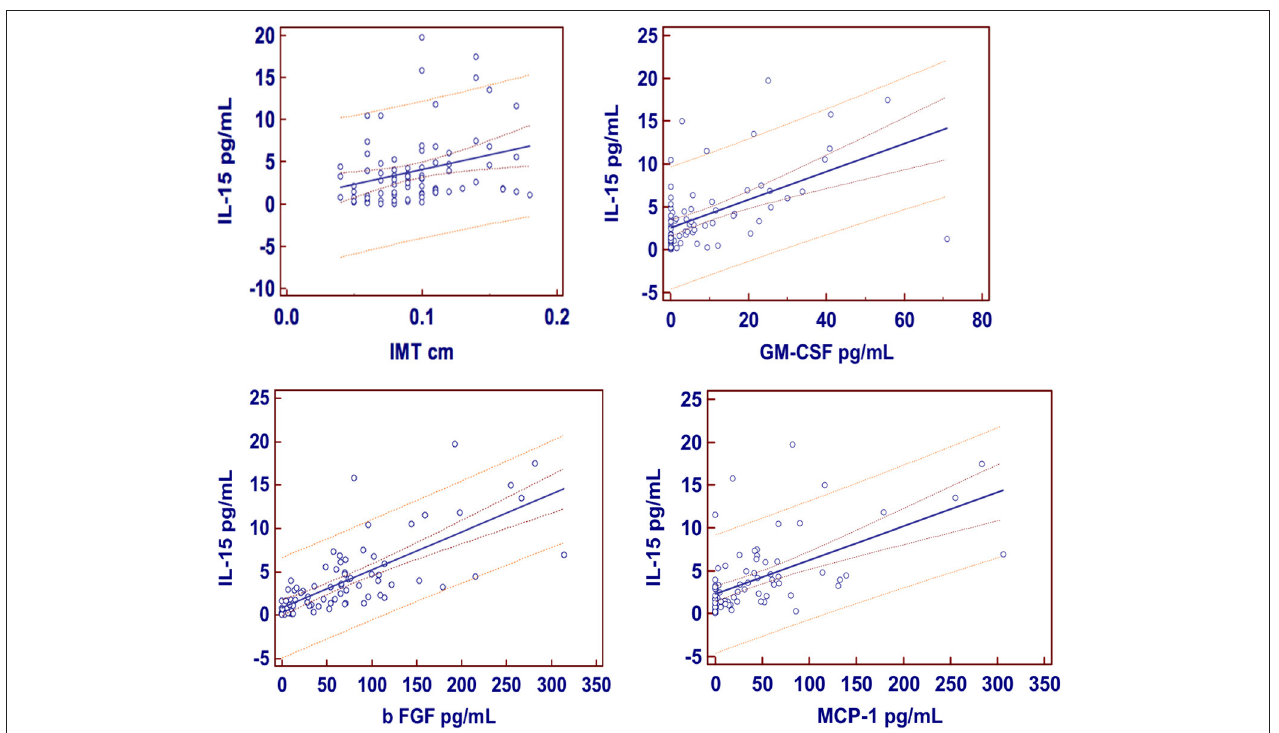
FIGURE 1 | Regression equations. Just at the center the regression line is showed; 95% confidence interval as lines nearest to the regression line and 95% prediction interval the more distant ones. IMT, Intima-media thickness; GM-CSF, granulocyte-macrophage colony-stimulating factor; b FGF, basic fibroblast growth factor; MCP-1, monocyte chemoattractant